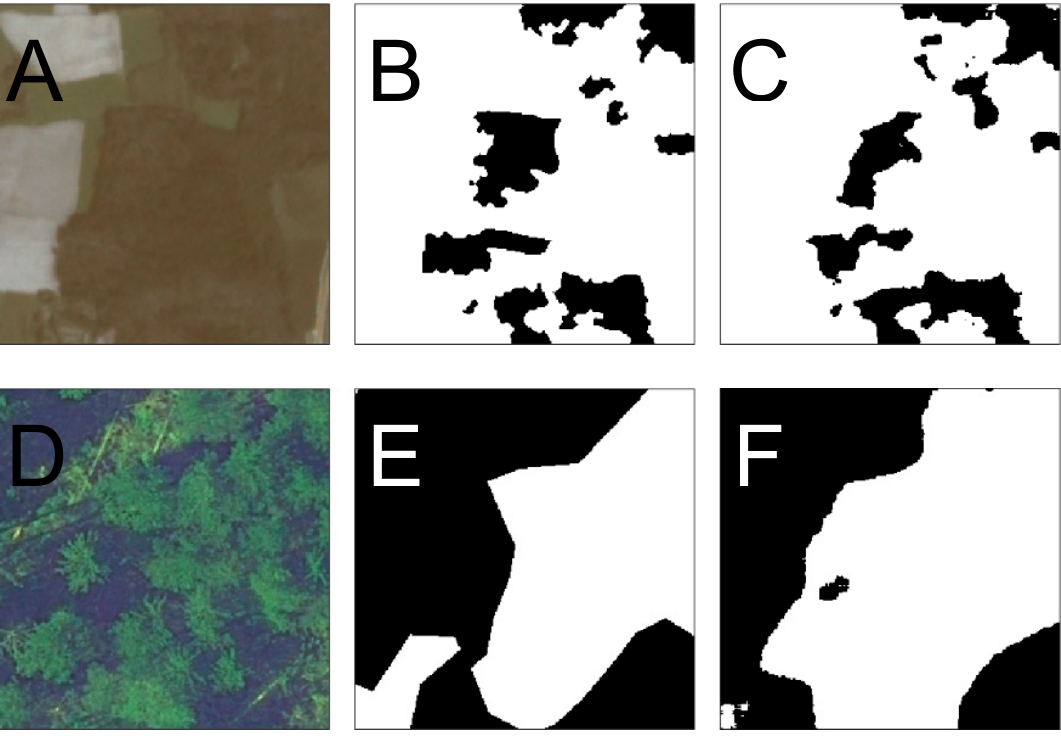
Figure 6. Image tile for Planet ( A – C ) and aerial data ( D – F ) together with the respective labeling and prediction prior to thresholding.